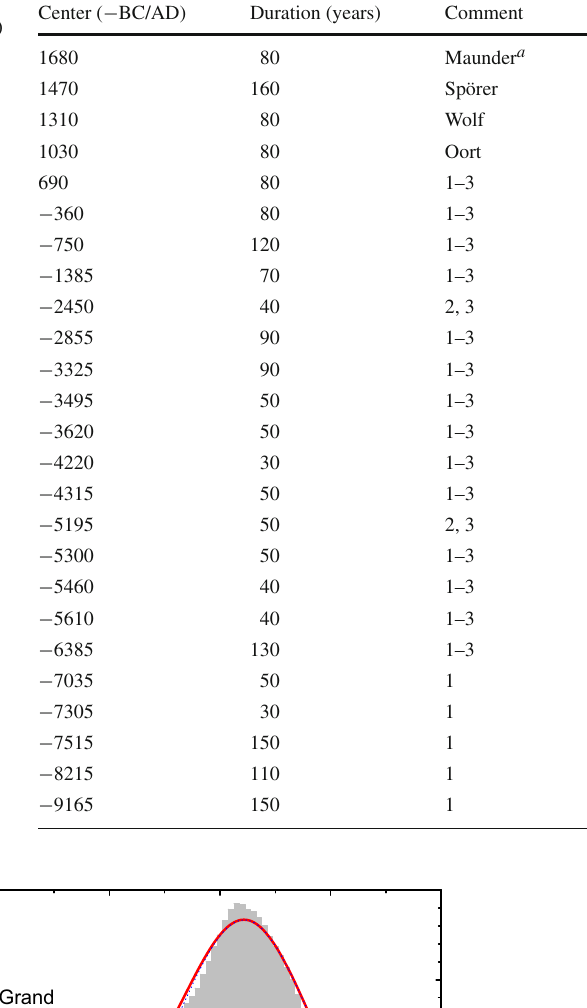
Table 2 Conservative list with approximate dates (in –BC/AD) of grand minima in reconstructed solar activity